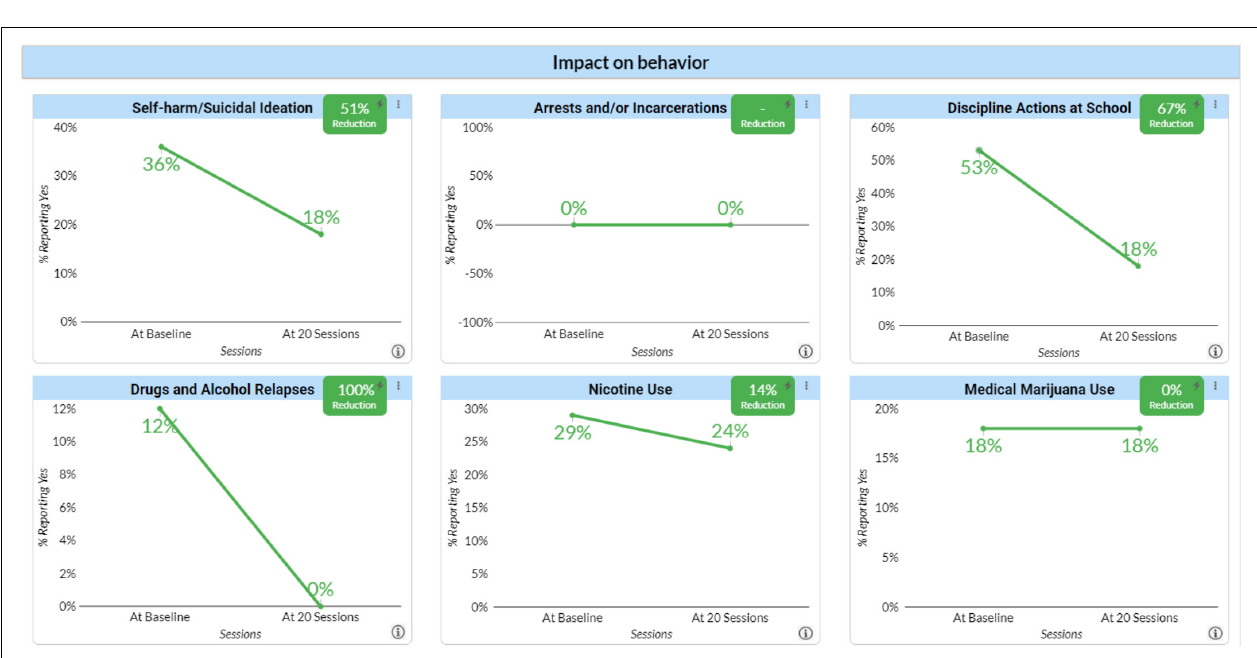
FIGURE 2 | Impact of neurofeedback on behavior. Clients reported the occurrence of behaviors such as self-harm/suicide ideation, arrest and/or incarceration, discipline action at school, drug and alcohol relapses, nicotine use, and marijuana use before and after receiving neurofeedback